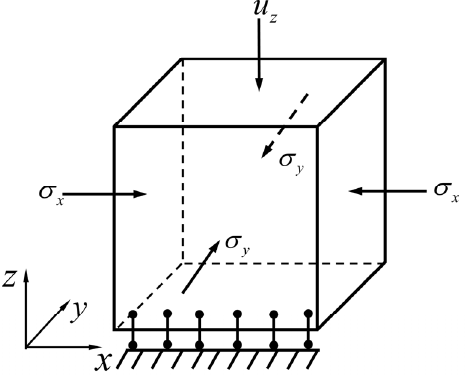
Figure 9. Numerical model of the triaxial compression test in FLAC 3D .